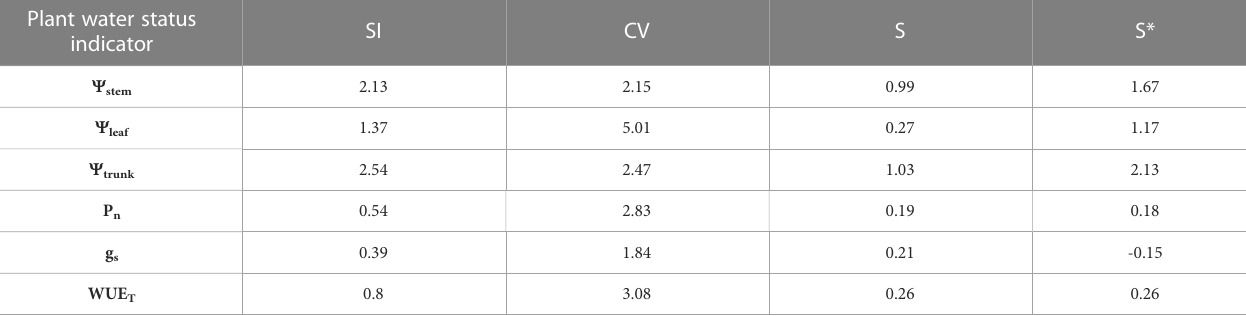
TABLE 1 Sensitivity analysis (SI: Signal intensity; CV: coef fi cient of variation; S: sensitivity (by Goldhamer and Fereres, 2001); and S*: corrected sensitivity (by De la Rosa et al., 2014) for the indicators of plant water status during the experimental period. Plant water status